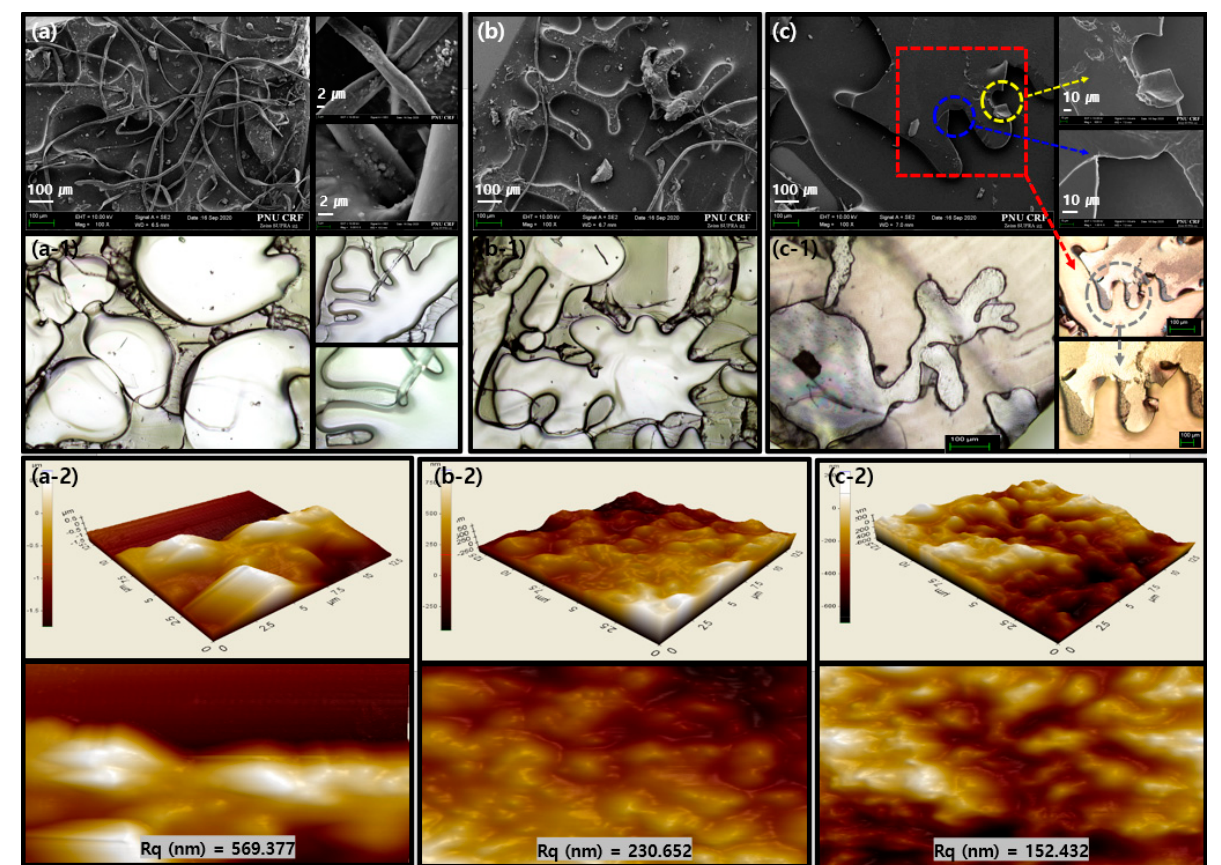
Figure 3. FE-SEM, optical microscopy and AFM images of PU-PSA interfaces after detachment to the adherend; ( a ), ( a-1 ), ( a-2 ): HDI/HDI trimer = 9/1, ( b ), ( b-1 ), ( b-2 ): HDI/HDI trimer = 8/2 and ( c ), ( c-1 ), ( c-2 ): HDI/HDI trimer = 5/5.